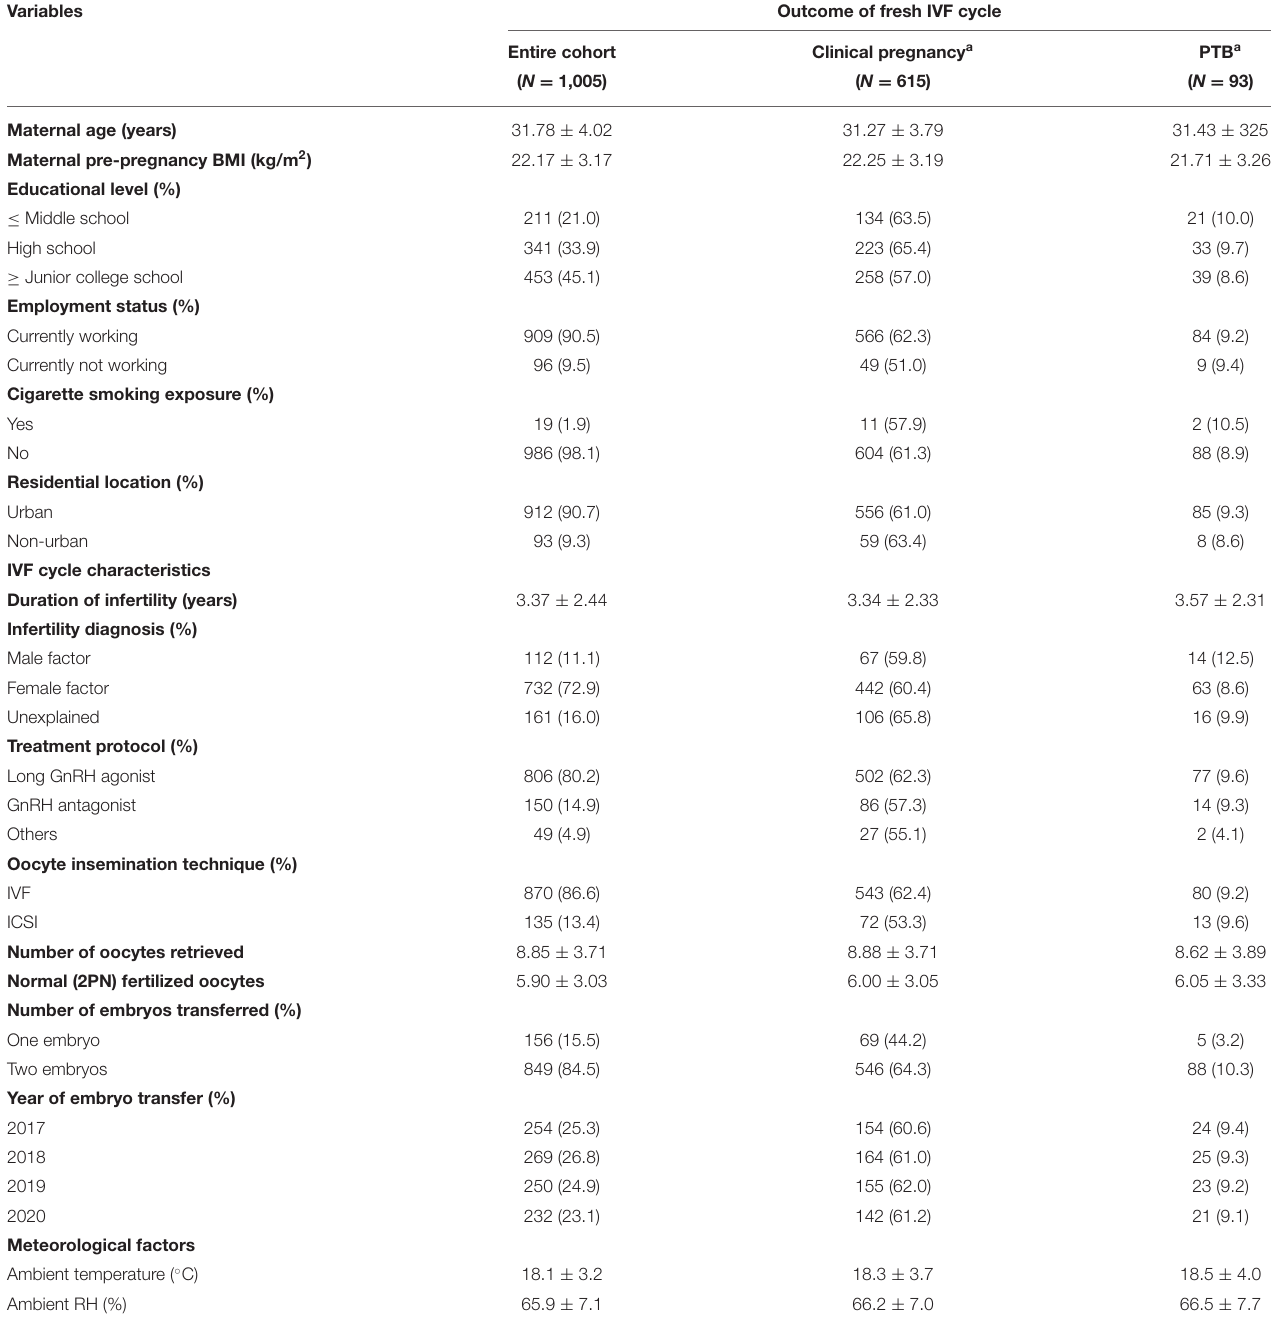
TABLE 1 | Descriptive statistics regarding subject demographic and clinical